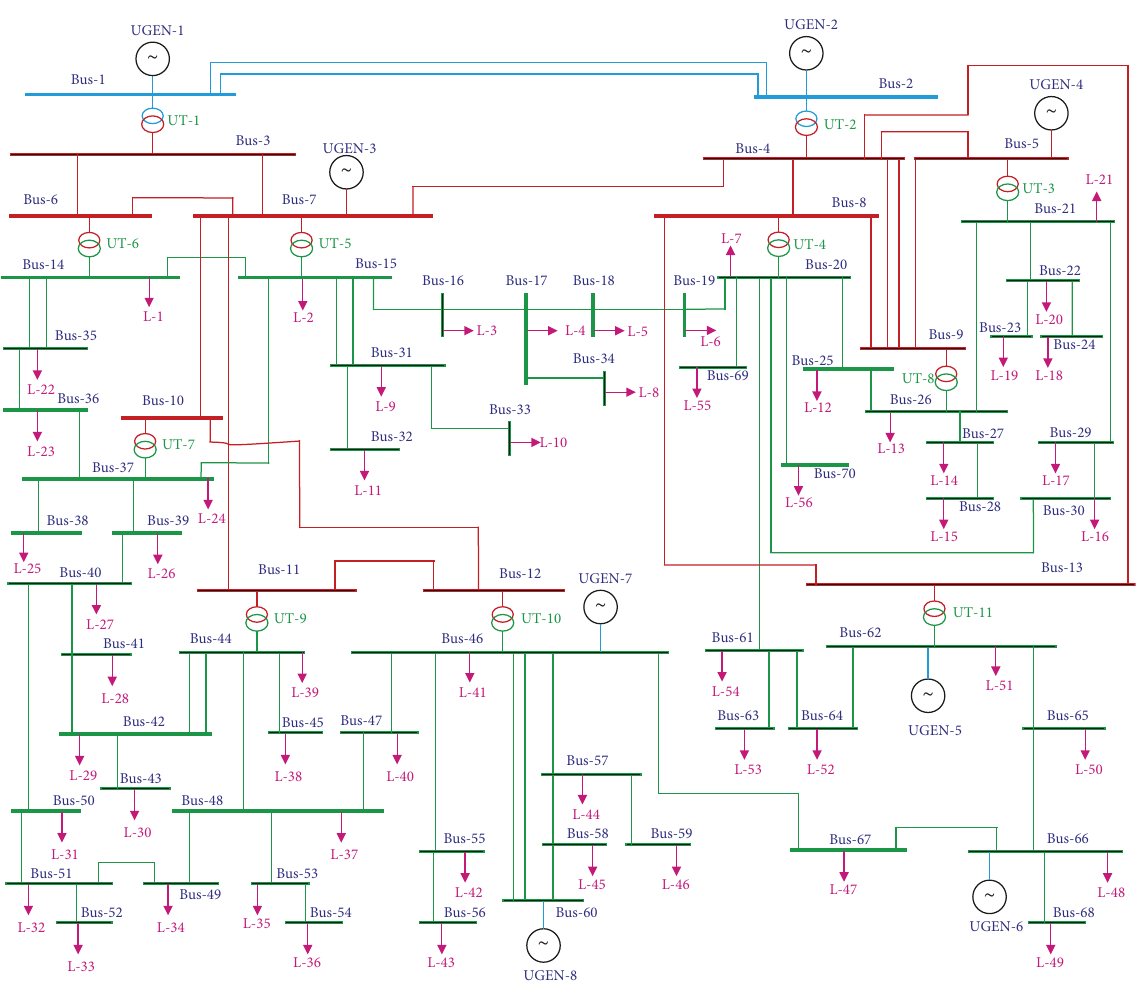
Figure 1: Transmission utility network in southern part of Rajasthan (Udaipur), India [17]. Table 1: Details of test system buses and loads (part-A)